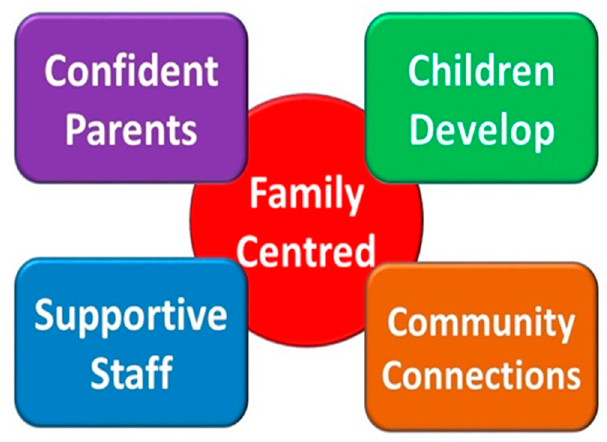
Figure 3. The main themes reported by parents of their experience of the service.